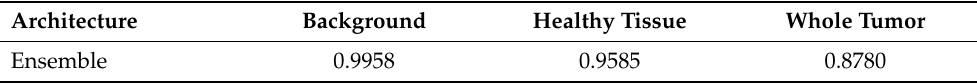
Table 6. Dice for Background, Healthy Tissue, and Whole Tumor obtained by the Ensemble Model. Architecture